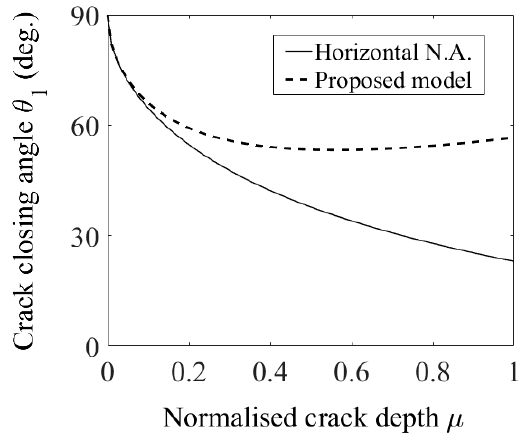
Figure 8. Comparison of the crack closing angle for the proposed model and horizontal neutral axis model.